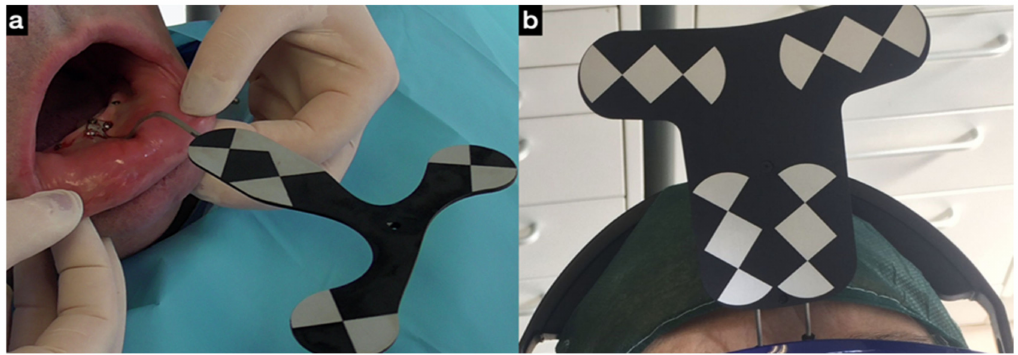
Figure 2. ( a )The jaw tracker anchored with three bone screws to the lower jaw where the surgery is planned; ( b ) the head tracker is alternatively used to track the maxillary